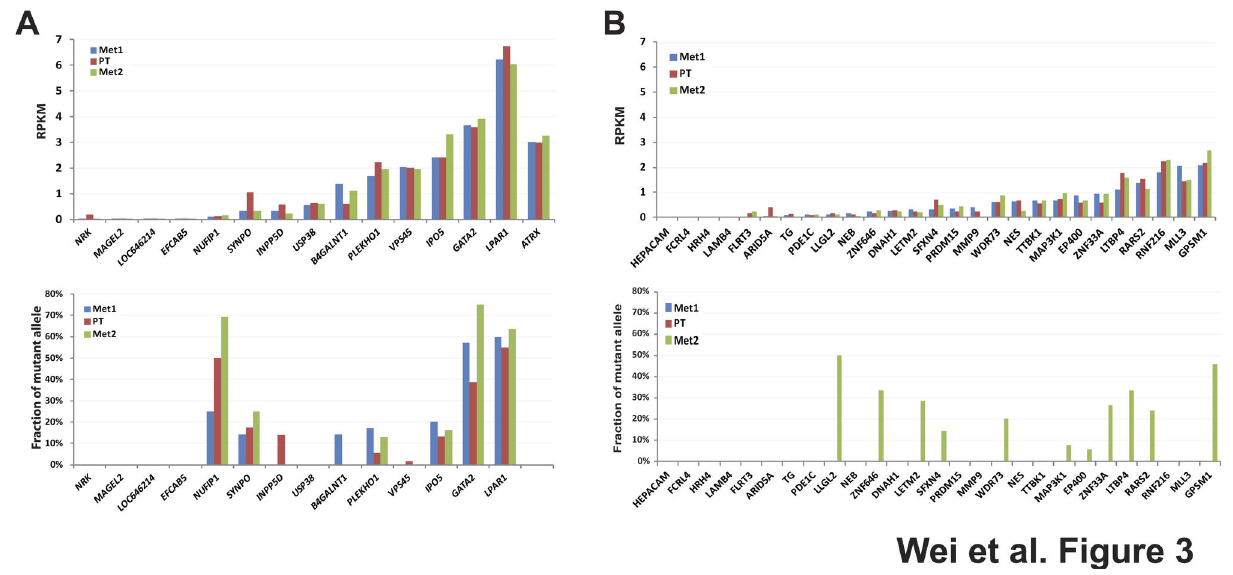
Figure 3. Transcriptome sequencing demonstrated that LPAR1 was the most highly expressed gene among the 15 commonly mutated genes. ( A ) Expression of 15 commonly mutated genes. Upper panel, normalized expression at the gene level was plotted for the 15 shared mutant genes in reads per kilobases of exon per million mapped reads (RPKM). Most genes were expressed at similar levels among all three tumors and LPAR1 was the highest expressed mutant gene. Lower panel, fraction of mutant allele transcripts was calculated at the mutant positions for 14 commonly mutated genes. ( B ) Expression of 30 mutated genes unique to Met2. Upper panel, Normalized expression at the gene level in reads per kilobases of exon per million mapped reads (RPKM). Lower panel, fraction of mutant allele